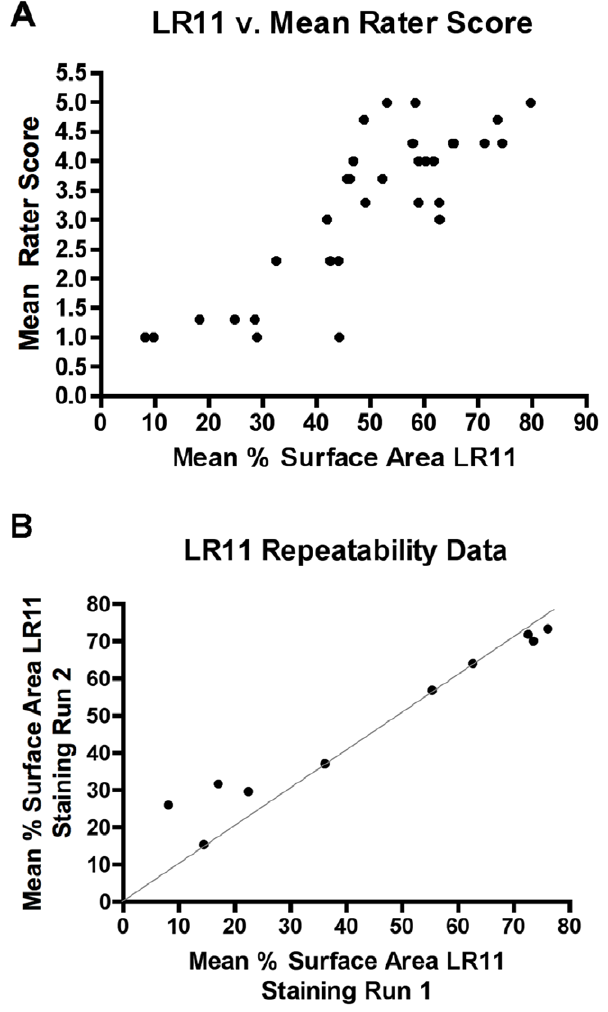
Figure 3. Verification of LR11 Quantitative Measures. (A) Three independent raters scored LR11 staining in 32 cases on a scale of 1 to 5 with 1 indicating little to no LR11 staining above background and 5 indicating strong LR11 staining. The quantitative LR11 measures and the average semi-quantitative scores from the three raters showed strong correlation (r=0.73, p , 0.0001), suggesting good agreement between the two methods. (B) To assess the consistency of the quantitative IHC approach, brain sections from 10 cases were re-stained and re-analyzed for LR11 expression in two independent experiments. Our method of measuring LR11 expression showed high reproducibility (intraclass correlation coefficient=0.94). In the figure, proximity to the 45 u line indicates closeness of the LR11 measures from the two runs. cases. Only the difference in NFT frequency in the frontal cortex